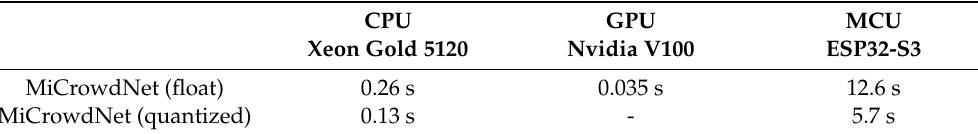
Table 2. MiCrowdNet inference latency comparison between CPU, GPU, and MCU. For comparison, we used the TensorFlow 32-bit float model and the quantized TensorFlow Lite 8-bit model. The input size was set as a 64 × 64 image.